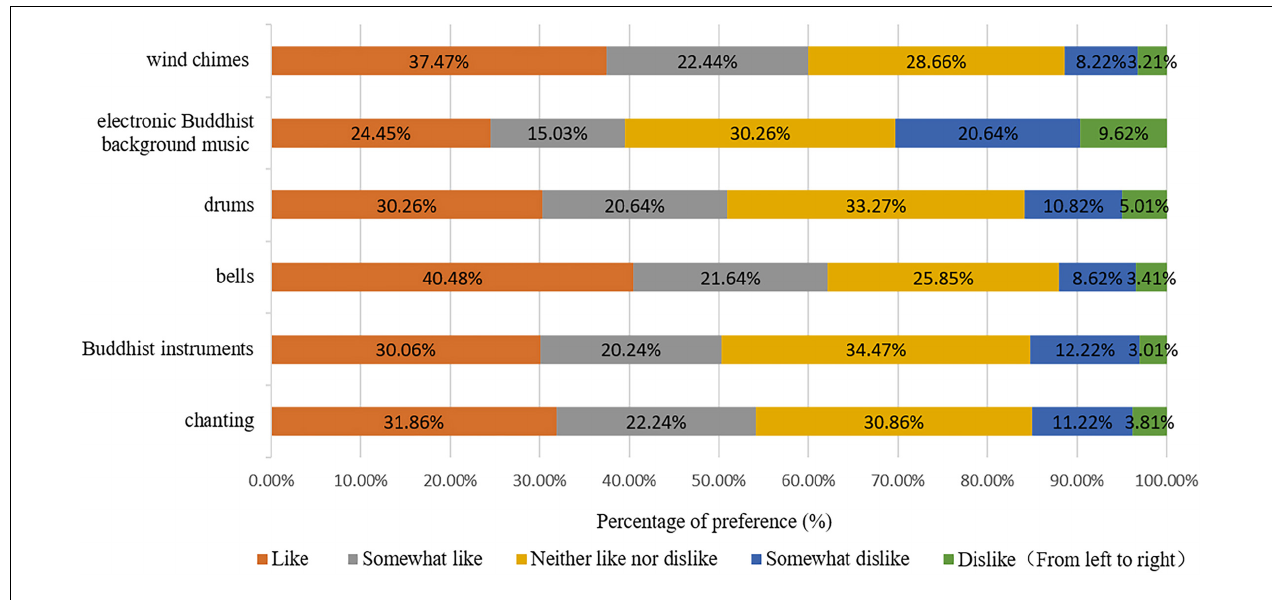
FIGURE 2 | Preferences for the six selected typical sounds in the